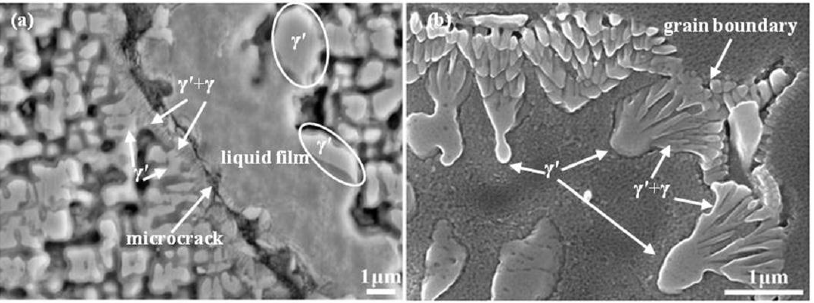
Figure 4. Liquid film in HAZ: ( a) γ′ phase in liquid film and ( b ) fine eutectics grown in liquid film.